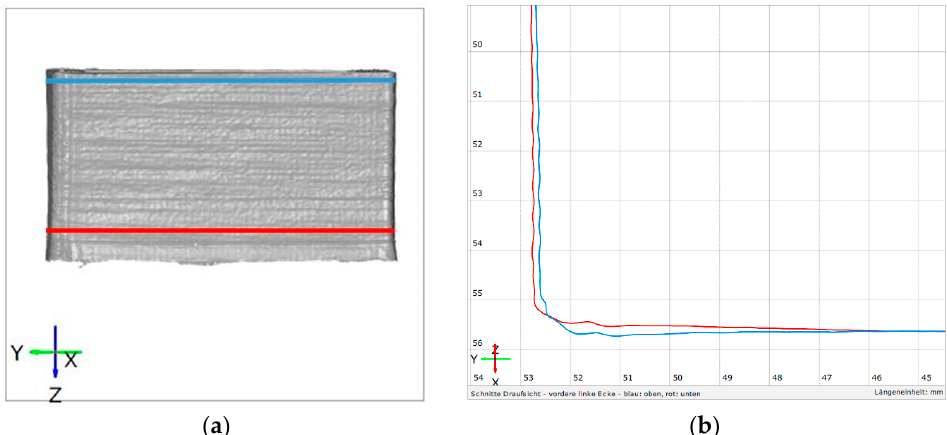
Figure 7. GOM measurement of square 1; ( a ): two investigated planes (blue and red); ( b ): superim- posed planes from top view; manufacturing direction: clockwise; solvent debinded.